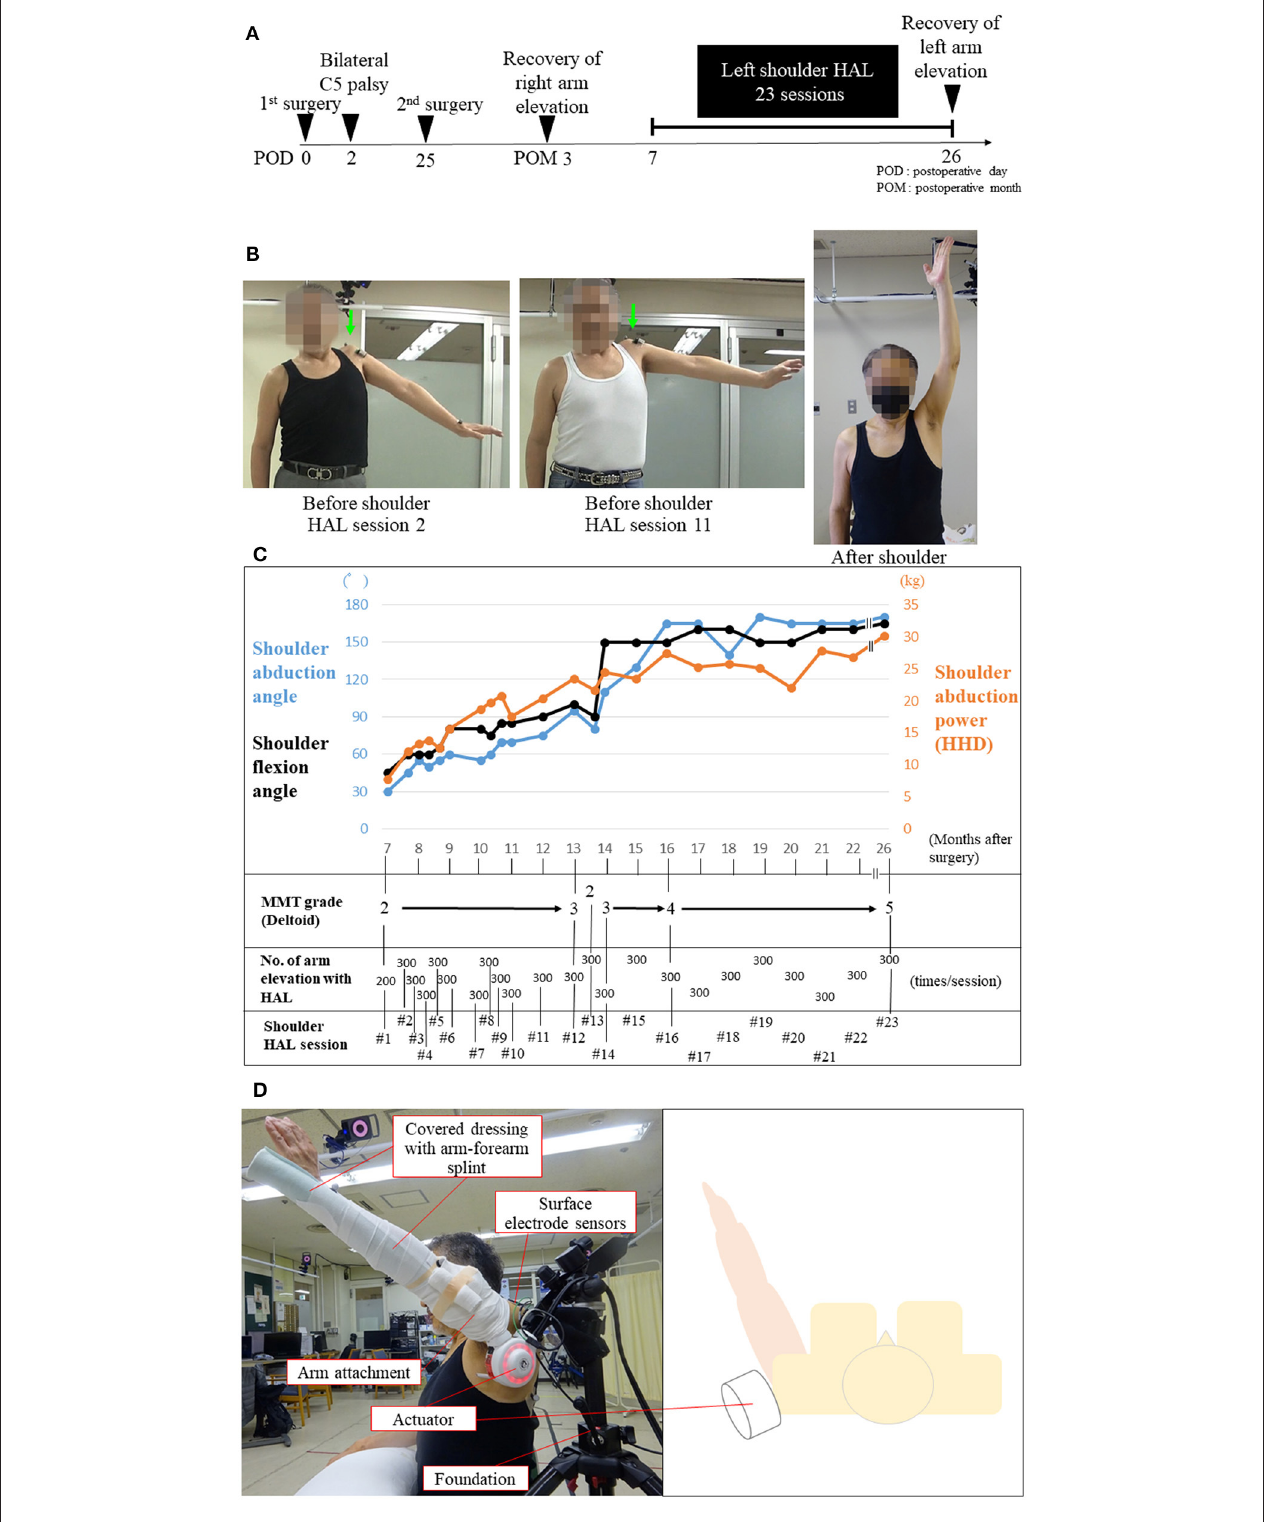
FIGURE 2 | Images demonstrating C5 palsy after surgery and during the shoulder Hybrid Assistive Limb (HAL) training (A,B) . Entire process of the shoulder HAL training of the patient (C) . Photographs illustrating shoulder HAL abduction training in the scapular plane (D) . (A) Schematic showing the time course of the development of and recovery from C5 palsy. (B) Photograph showing maximum abduction of the left shoulder. Before the second and 11th HAL training sessions, his